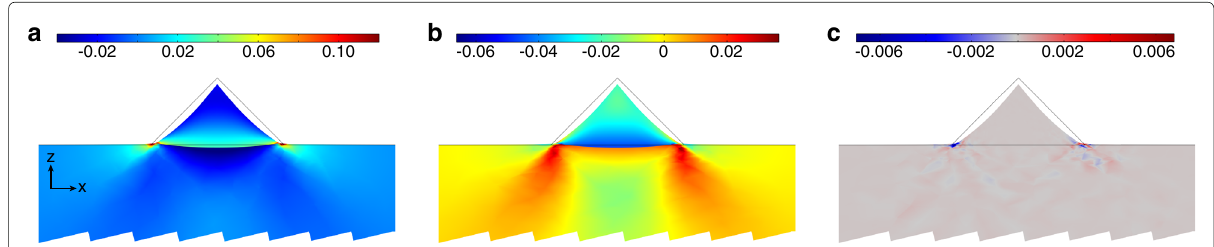
Fig. 2 Residual strain distribution of a GeNW in situation A with the basal width of 40 nm: a x component strain ε xx , b z component strain ε zz , and c shear strain in x-y plane ε xy . The zigzag shape at the bottom denotes the partial substrate layer (the following has the same